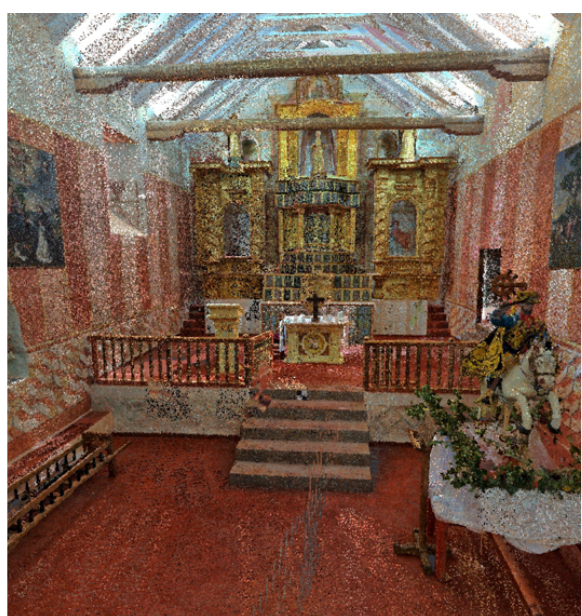
Figure 6. Consolidated interior Point Cloud of the church. Image by CIMS © GCI 2019.